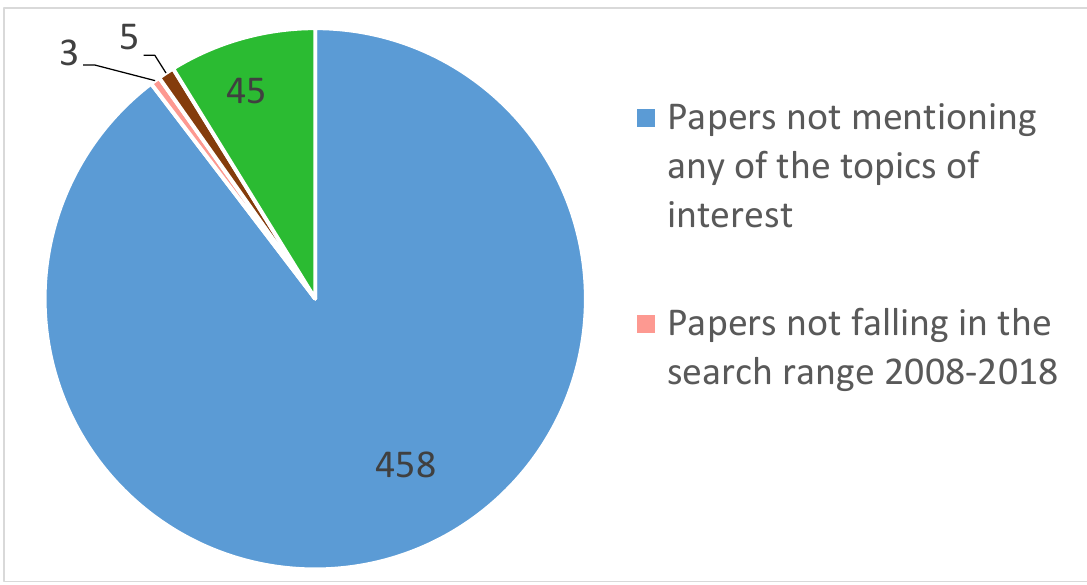
Figure 6. Reasons for the exclusion of certain papers from the review (source: own study).